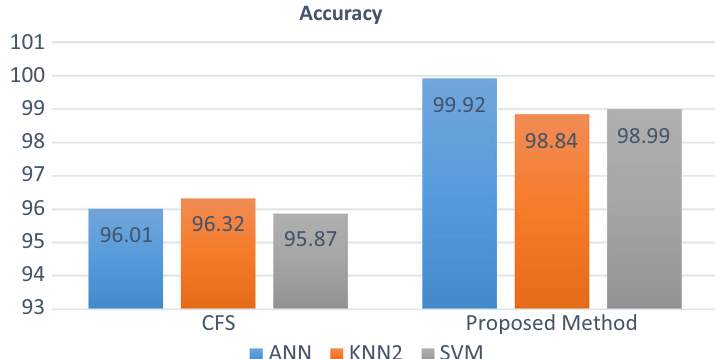
Fig. 10 Comparison proposed method and CFS method on P- dataset